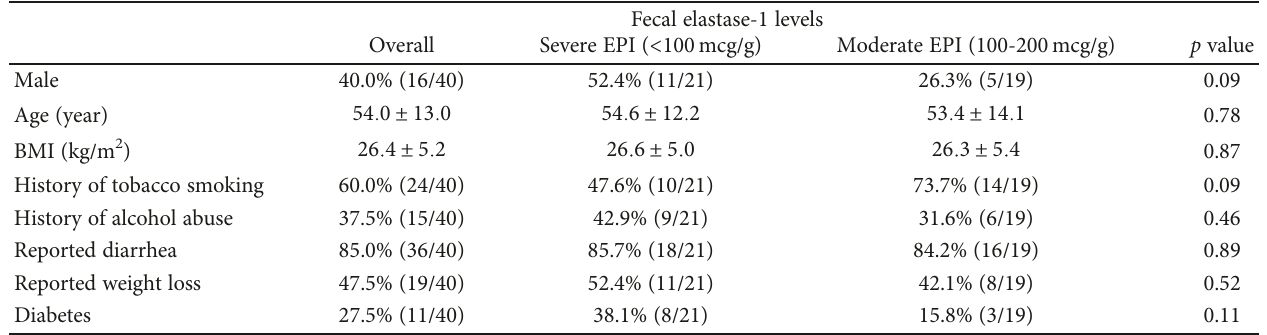
Table 1: Demographic, anthropometric, lifestyle factors, and presenting symptoms of study